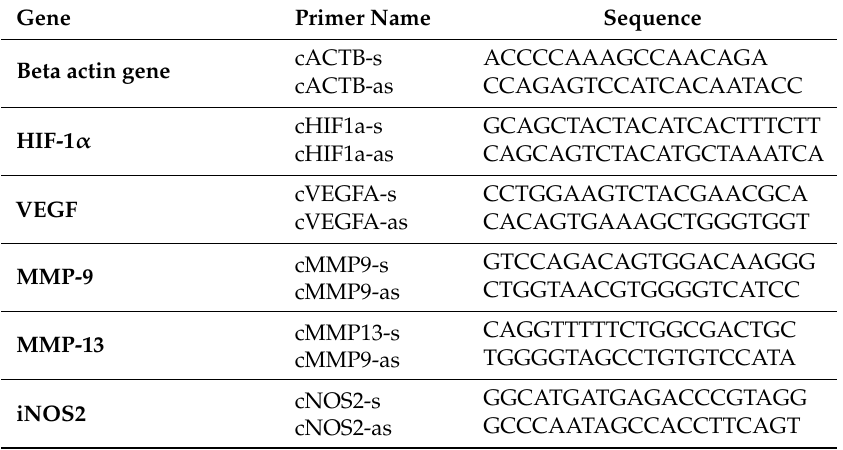
Table 2. Primers used for quantitative polymerase chain